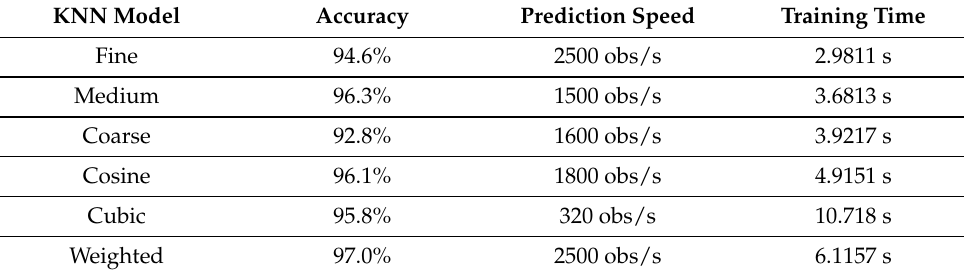
Table 5. Accuracy of KNN